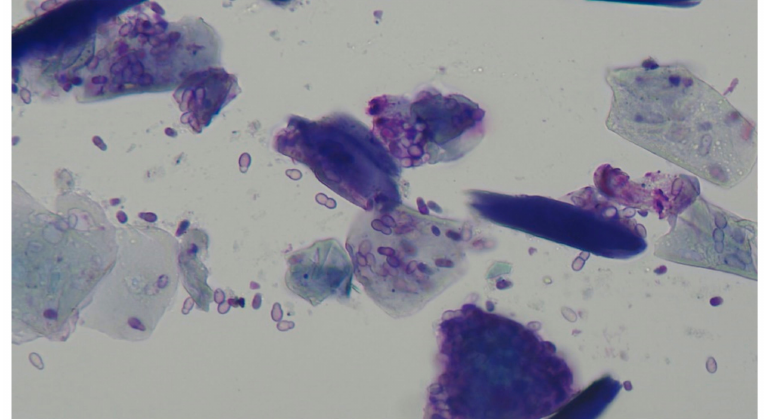
Figure 8. Malassezia pachydermatis yeast in a cytology smear from the external ear canal of a dog with malassezial otitis externa. Courtesy Prof. R. Bond, Royal Veterinary College, Hawkshead Lane, Brookmans Park, Hatfield AL9 7TA.